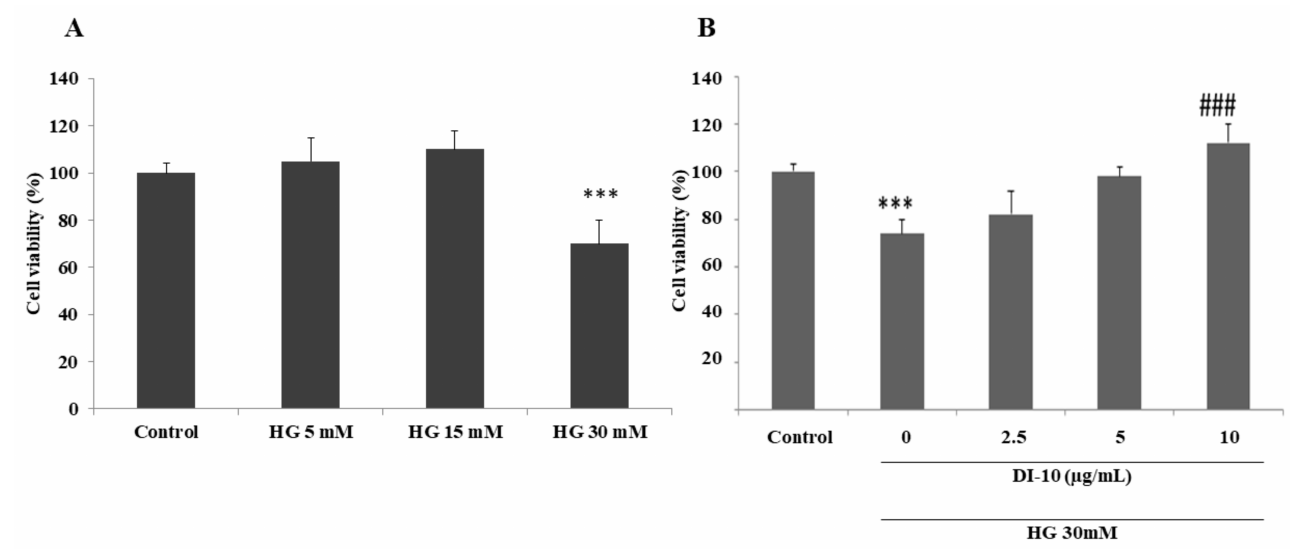
Figure 3. DI-10 improves the viability of C2C12 myoblast cells under high glucose stress. ( A ) C2C12 cells were treated with different concentrations of D-glucose (5, 15, and 30 mM) and the cell viability was determined with MTT assay. ( B ) C2C12 cells were treated with 30 mM HG followed by different concentrations of DI-10. *** p < 0.001 compared to control groups and ### p < 0.001 compared to the high glucose.